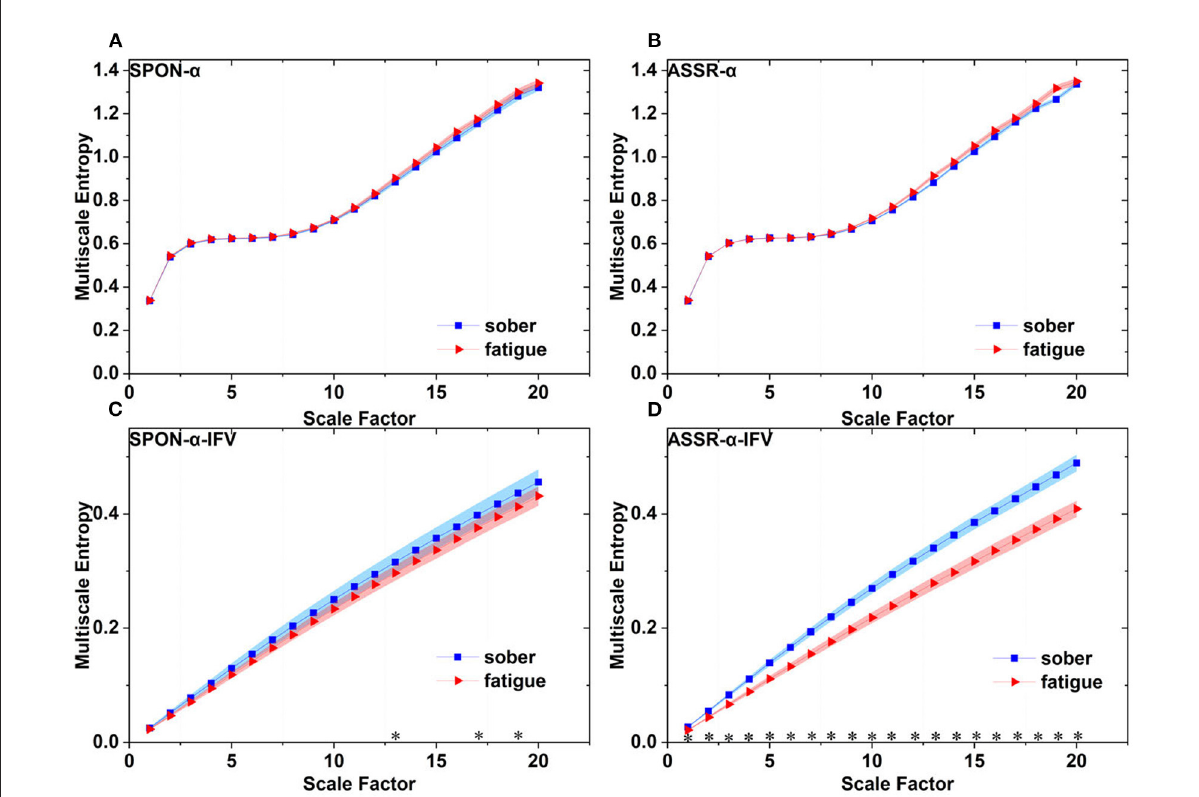
FIGURE6 Comparison of MSE from frontal lobe (channel F3) on: (A) alpha rhythm from spontaneous EEG (SPON- α ), (B) alpha rhythm from ASSR (ASSR- α ), (C) IFV in alpha rhythm from spontaneous EEG (SPON- α -IFV), and (D) IFV in alpha rhythm from ASSR (ASSR- α -IFV). The sign * indicates significance at p < 0.05. Shades indicate the standard